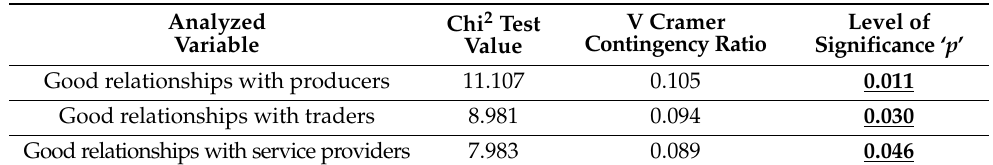
Table 2. Dependencies between opinions about the importance of good relationships with offerors and the perception of offerors as entities that listen to purchasers’ opinions and take advantage of their willingness to